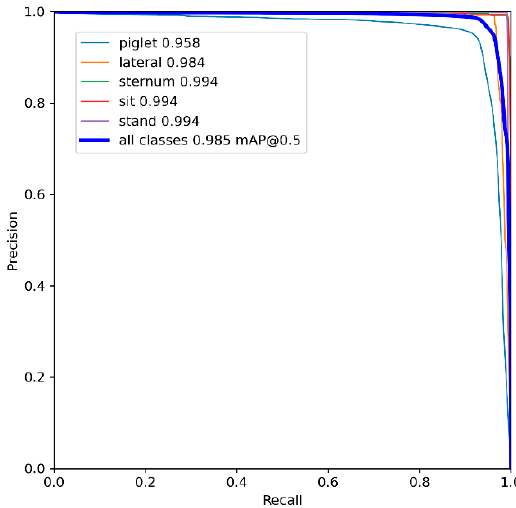
Figure 6. P-R curve for YOLOv5s_DataAug. Table 1. Evaluation indices of different algorithms for sow posture and piglet object detection.